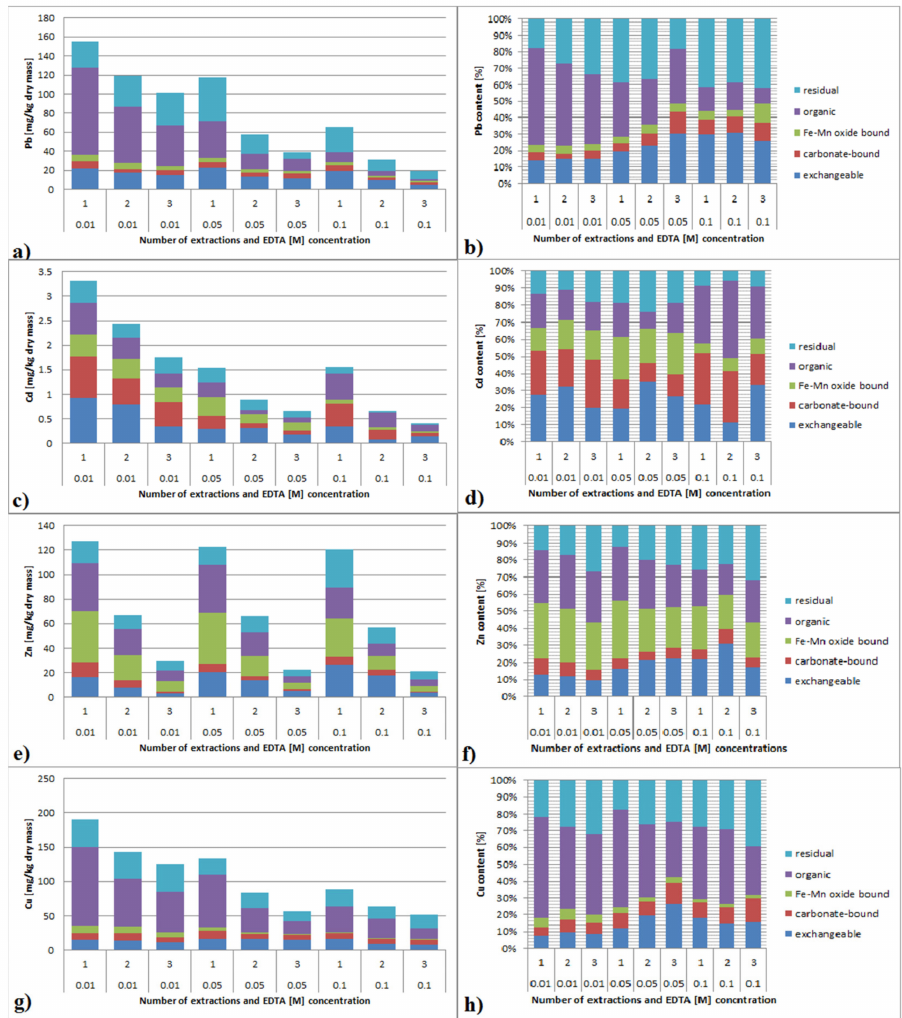
Figure 7. ( a – h ). Speciation and content of trace metals after multiple EDTA